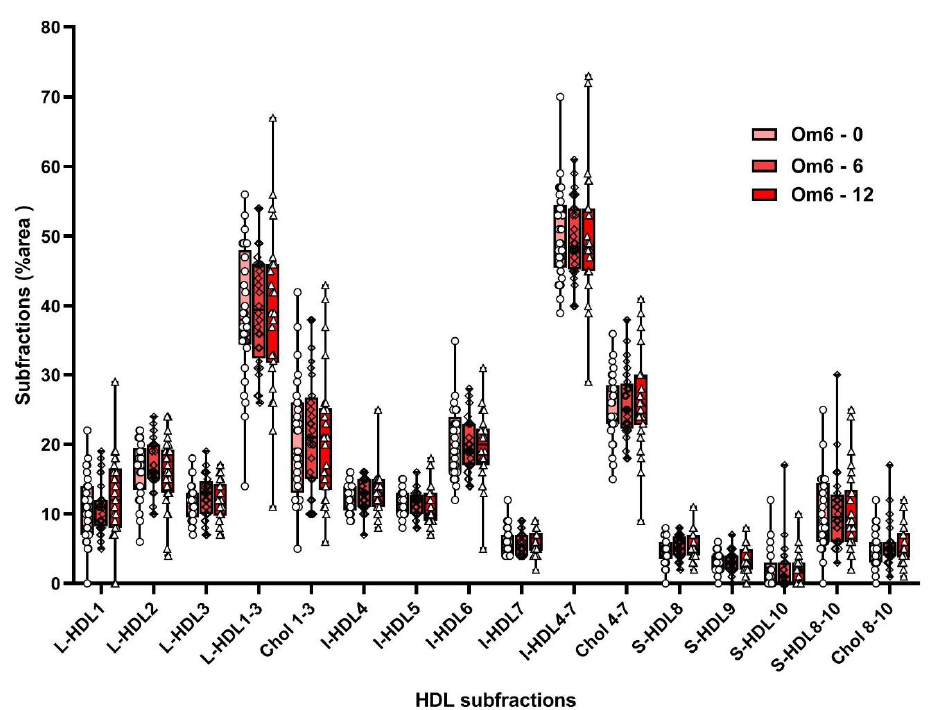
Figure 6. HDL subfractions in Om6 group at the baseline and after 6 and 12 weeks of supplementation. HDL—high-density lipoprotein, L-HDL—large HDL subfraction, I-HDL—intermediate HDL subfraction, S-HDL—small HDL subfraction, Chol—cholesterol, Om3—omega 3 group.